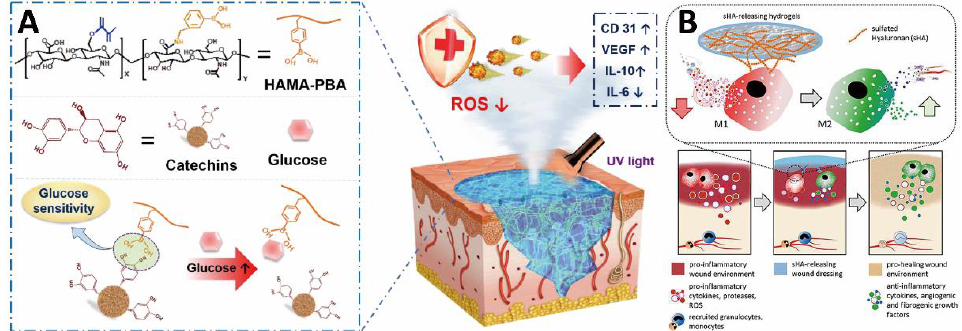
Figure 3. HA-based hydrogel bio-adhesives: ( A ) schematic diagram illustrating the glucose-responsive antioxidant hydrogel bio-adhesive for diabetic wound healing. Reprinted with permission from ref [57]. Copyright 2022 Elsevier. ( B ) Schematic illustration of modulation of inflammatory macrophage activity by hydrogel bio-adhesive. Reprinted with permission from ref [94]. Copyright 2021